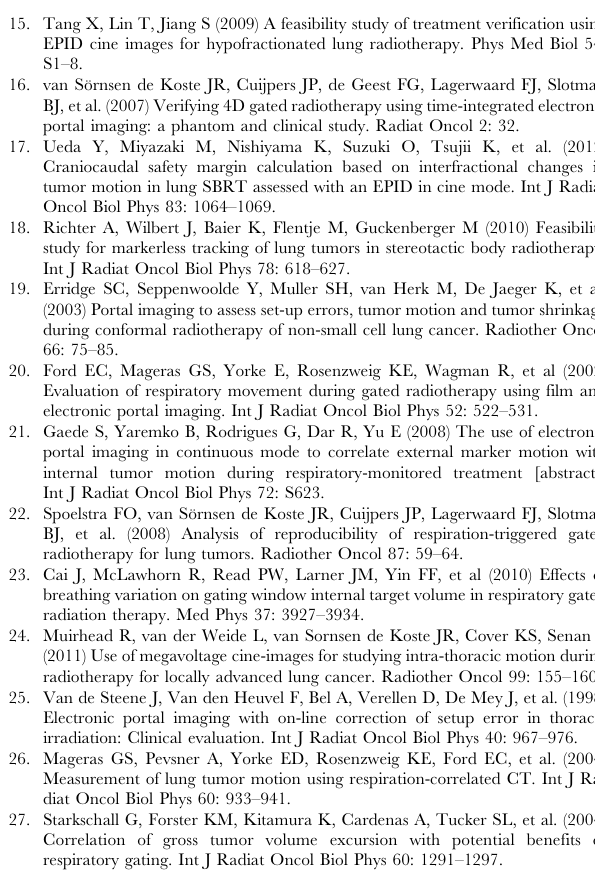
Table S1 Tumor characteristics and respiratory mo- tion. Table S2 Inter-observer variation in tumor localization. Table S3 Tumor position variability during treatment in group A. Table S4 Tumor position variability during treatment in group